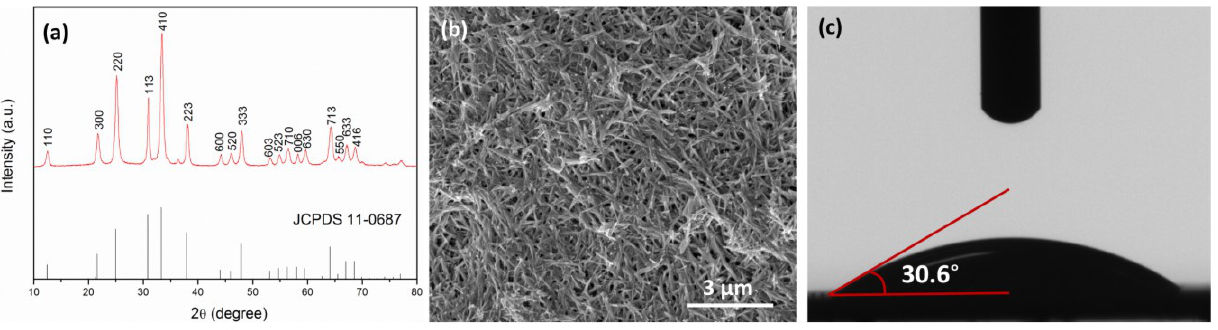
Figure 1. ( a ) XRD pattern of Zn 2 GeO 4 nanowires; ( b ) SEM images of Zn 2 GeO 4 nanowires; ( c ) contact angle measurement of Zn 2 GeO 4